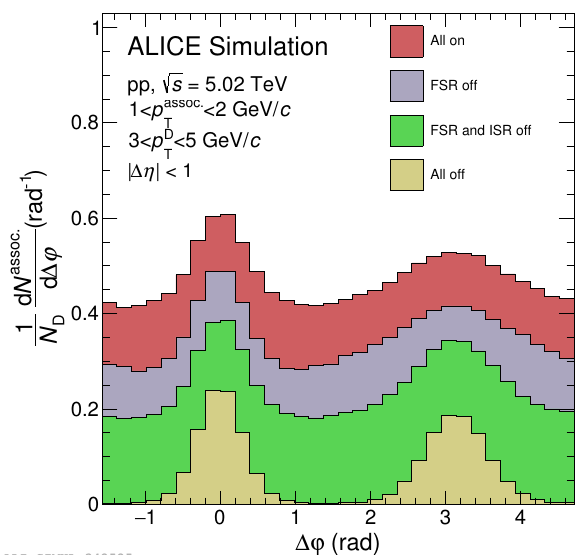
Figure 2. Associated yield of D–h correlations from simulations with different parton level con- tributions of prompt D mesons with hadrons in simulated pp collisions at 1 < p assoc. T